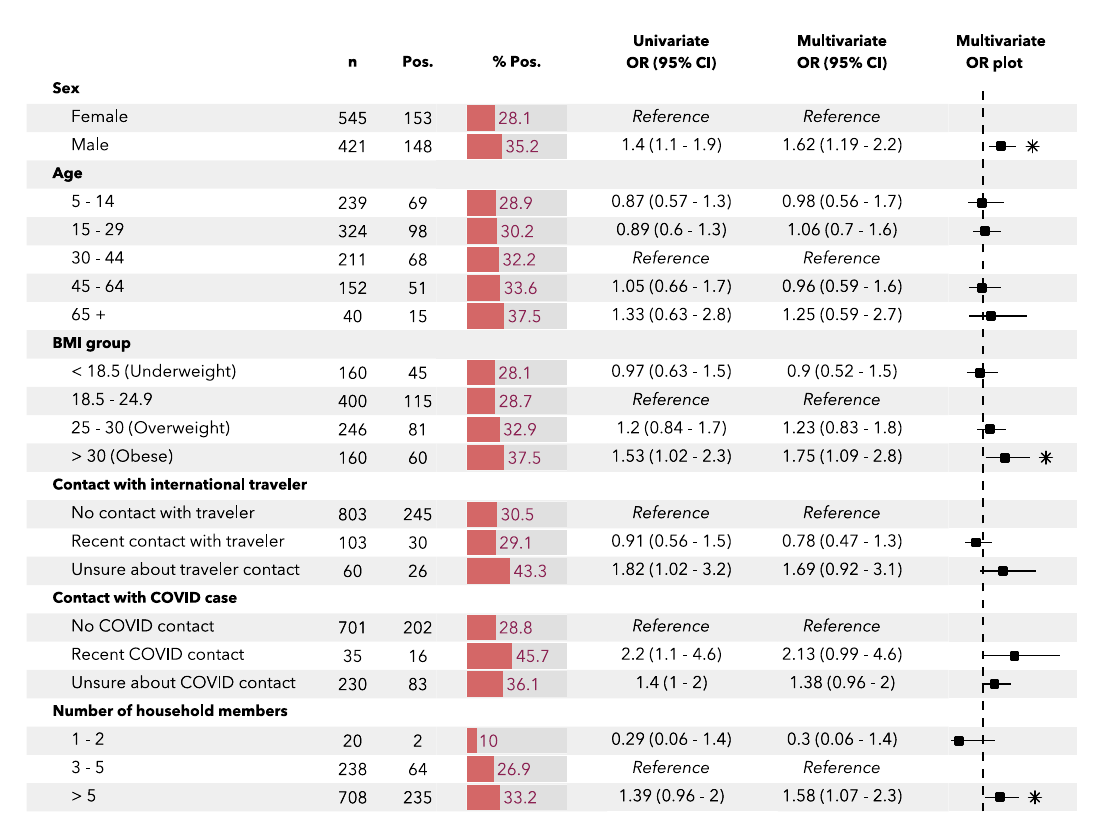
Fig. 2 Risk factor analysis for crude IgG seropositivity n = 966. Based on logistic models with household random intercepts. Box-whisker plot indicates odds ratio and 95% con fi dence interval. Asterisks indicate signi fi cance at a 0.05 alpha level. Five individuals were dropped due to missing covariables. Recent contact indicates contact since March 1, 2020. Variables that were found not to be signi fi cant at a 0.30 alpha level, and which were not controlled for in the multivariable regression, include: presence of comorbidities, breadwinner status, adherence to social distancing rules, household neighbourhood and presence of children in the household. BMI body mass index, n number of individuals, Pos positive, OR odds ratio, CI con fi dence